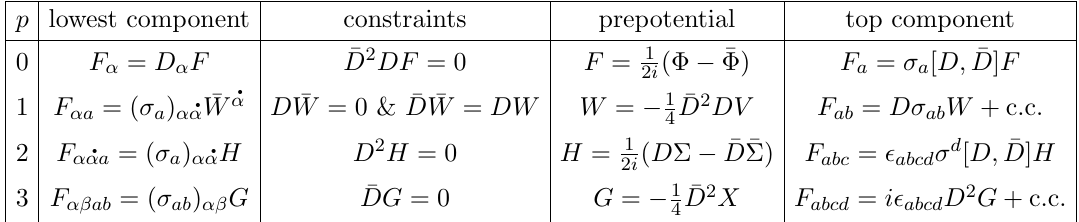
Table 2 . Conventional embedding of p -forms in closed superforms. The component p -forms are embedded into closed super ( p + 1)-form (cid:12)eld strengths F as originally shown in [17]. Each (cid:12)eld strength can be written in terms of an invariant scalar or spinor super(cid:12)eld. These satisfy constraints that can be solved in terms of prepotentials. Overall numerical constants have been neglected